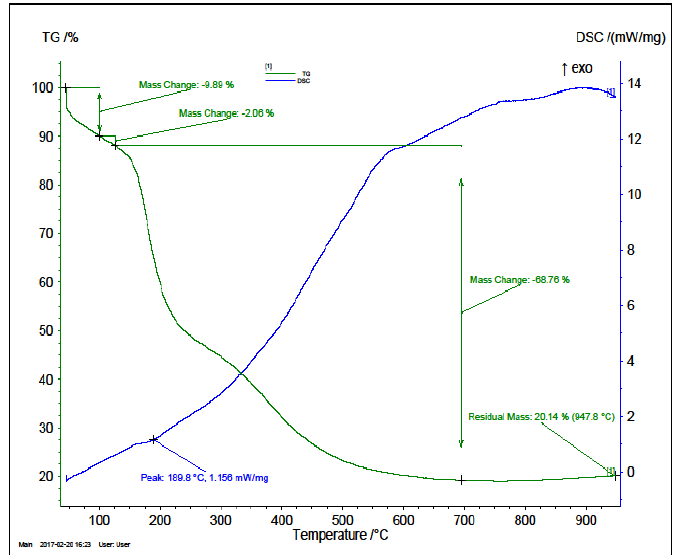
Figure 8. TGA and DSC of nanocellulose.